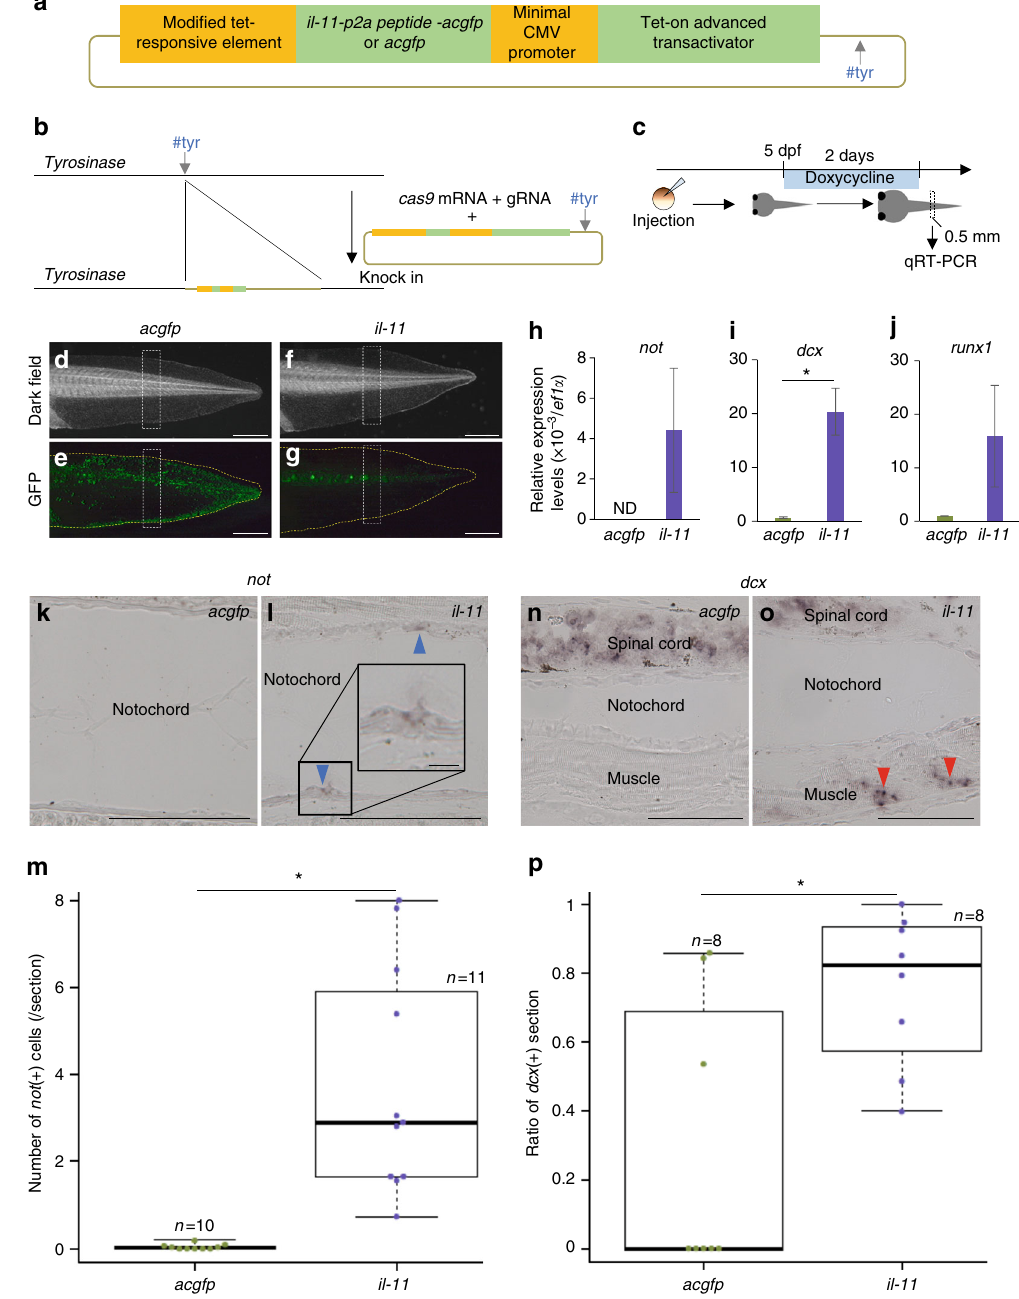
Fig. 6 il-11 is suf fi cient for induction of progenitor cells across cell lineages in intact tadpole tail. a Schematic drawing of a construct for forced expression of il-11 . Yellow boxes represent cis-regulatory elements, and green boxes represent coding sequences. gRNA #tyr target site was inserted in the construct. In the control construct, acgfp was inserted instead of il-11-p2a peptide-acgfp . b Schematic drawing of knock-in. Dark grey arrows : gRNA #tyr target sequences. c Schematic drawing of a gain of function experiment. d – g , Representative images of tadpoles used in this experiment. acgfp - d , e or il-11 - f , g expressing tails 2 days after doxycycline treatment are shown. Tail tissues indicated in white broken lines from approximately 10 tadpoles were used for qRT-PCR. Dark- fi eld images d , f and GFP2- fi ltered images e , g are shown. Scale bars : 1 mm. Anterior is to the left , dorsal is up . Yellow broken lines indicate outline of the tails. h – j , Expression levels of not h , dcx i , or runx1 j in tails expressing acgfp or il-11 were measured by qRT-PCR. Vertical axes represent relative expression levels normalised by those of ef1 α . Mean ± s.e.m. n = 3. k , l , n , o , Representative ISH images for not k , l or dcx n , o in acgfp k , n or il-11 l , o -expressing intact tadpole